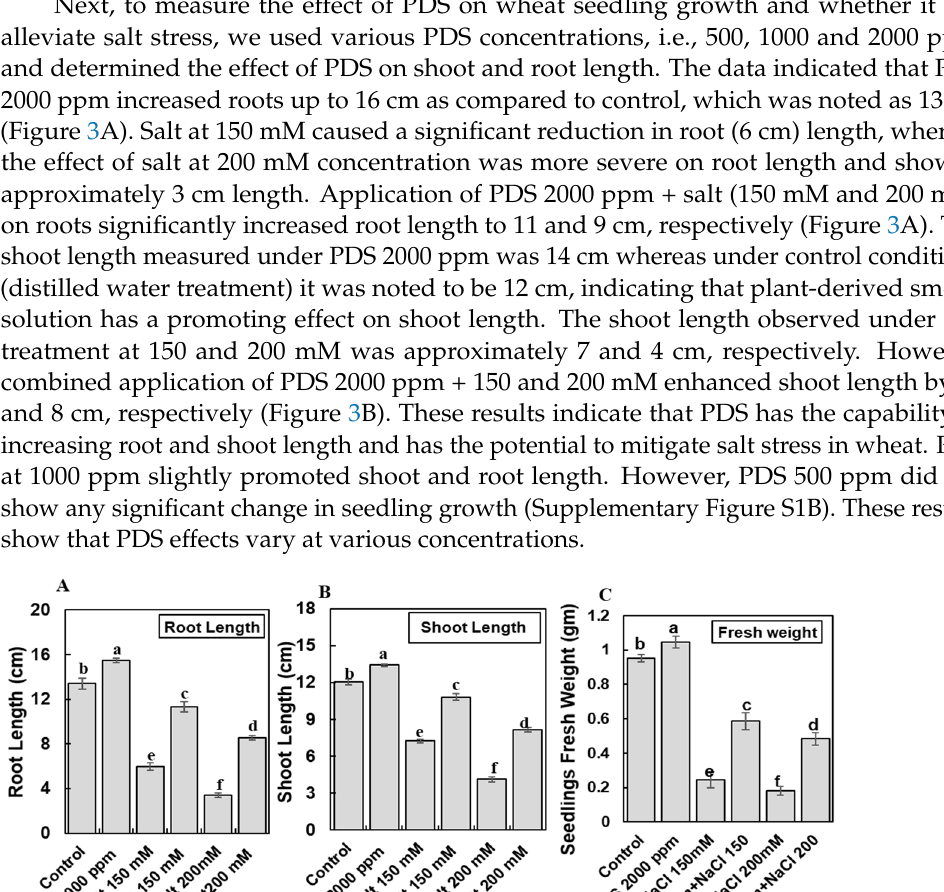
5 of 16 levels of germination negative marker genes in wheat. The y -axis shows fold change in the expres- sion of genes. The x -axis represents the different treatments. All data were analyzed using one-way ANOVA, with multiple comparisons using LSD test at a significance threshold of p ≤ 0.05. Three independent experiments were performed to obtain mean values and standard error bars for each germination experiment. The different lowercase alphabets represent homogeneous subsets and it’s indicates the statistical significantly according to Fisher LSD at level p < 0.05